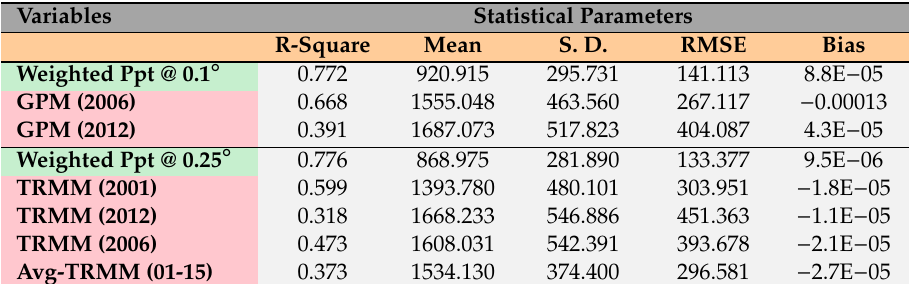
Table 4. Comparison between the weighted precipitation and neutral precipitation variables.